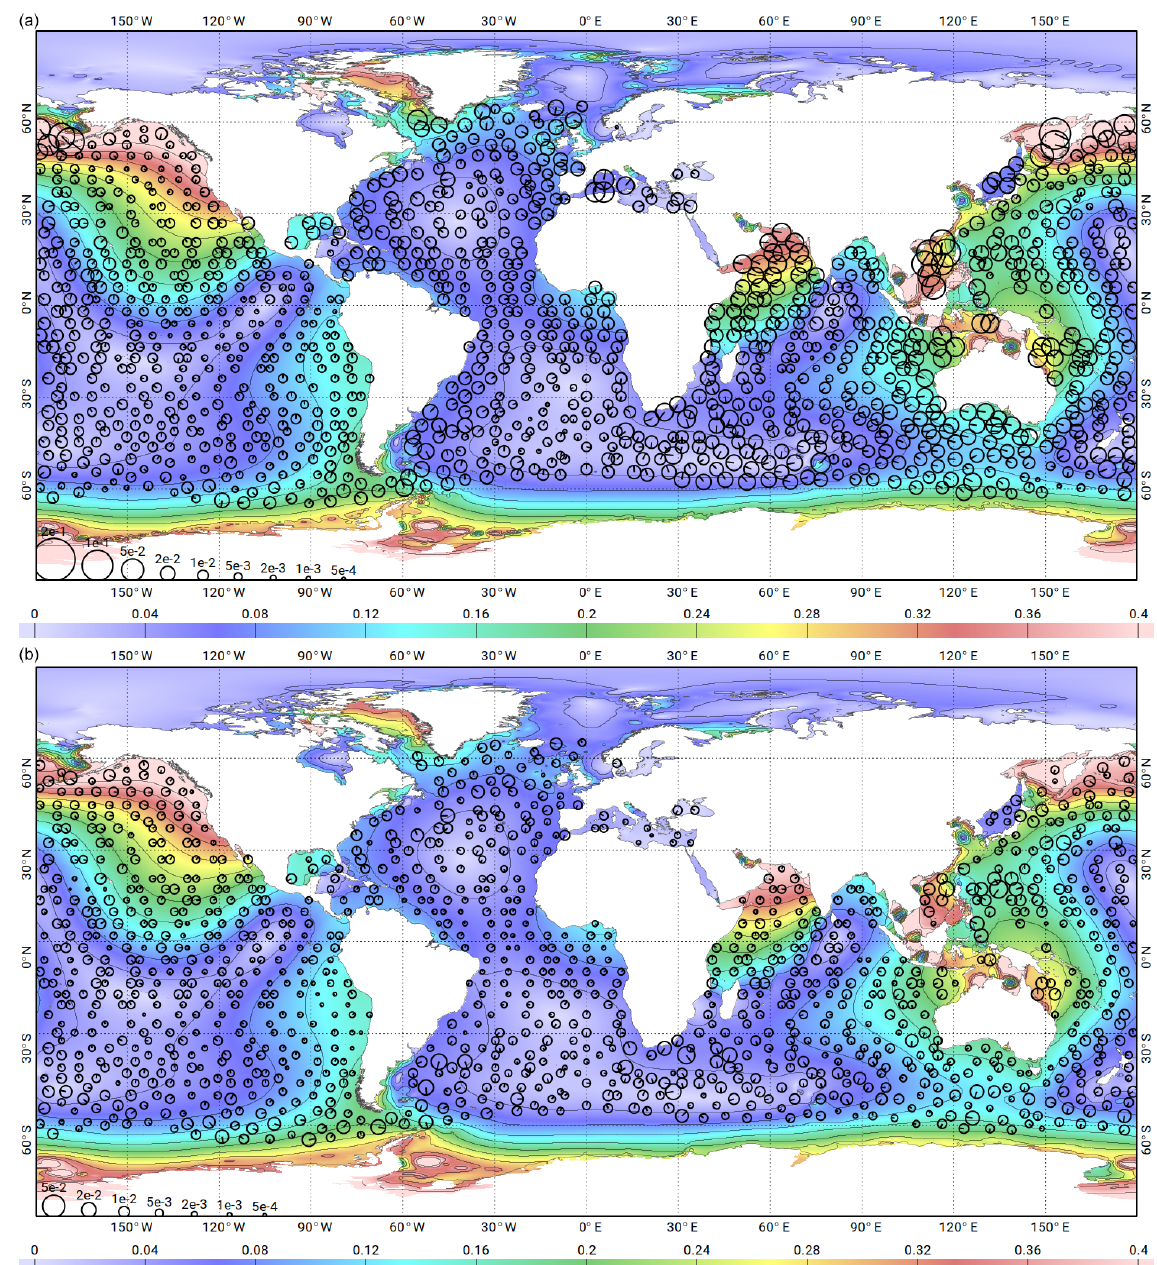
Figure 3. Vector differences (black circles) between the purely hydrodynamic solutions of FES2012 (a) and FES2014 (b) , and the deep TP/J1/J2 altimeter crossover points, for the K1 tidal component. The accuracy improvement between the FES2012 and FES2014 prior solutions is a key ingredient in the accuracy improvement between the FES2012 and FES2014a/b/c assimilated solutions. The size of the black circles is proportional to the square root of the amplitude of the vector difference between the solutions and the observations (see bottom left normalized symbols; units are in metres). The line inside circles shows the vector difference phase. The background colour shows the amplitude of the M2 tidal component from the model (in